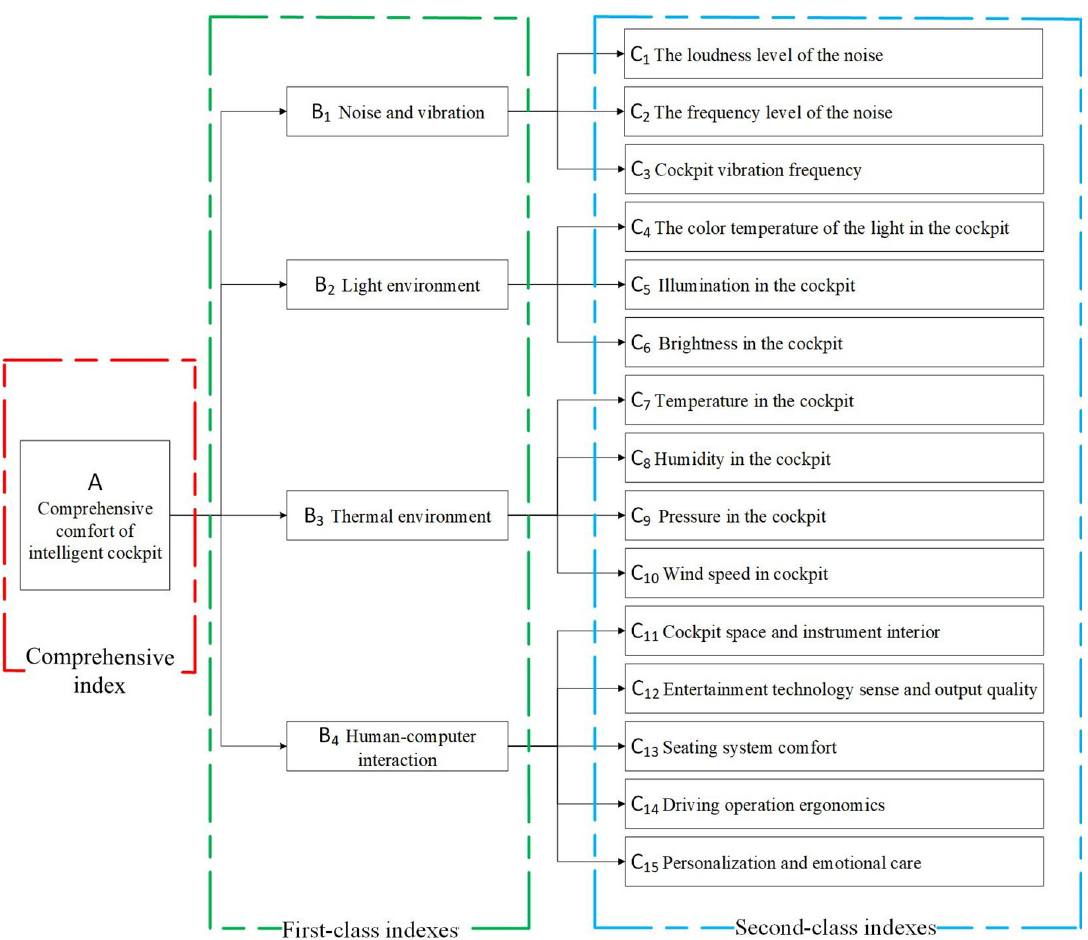
Fig 1. Evaluation system of comfort indexes of intelligent cockpit. The cockpit system consists of three parts. The content in the red box represents the comprehensive index. The content in the green box represents the first-class index. The content in the blue box represents the second-class